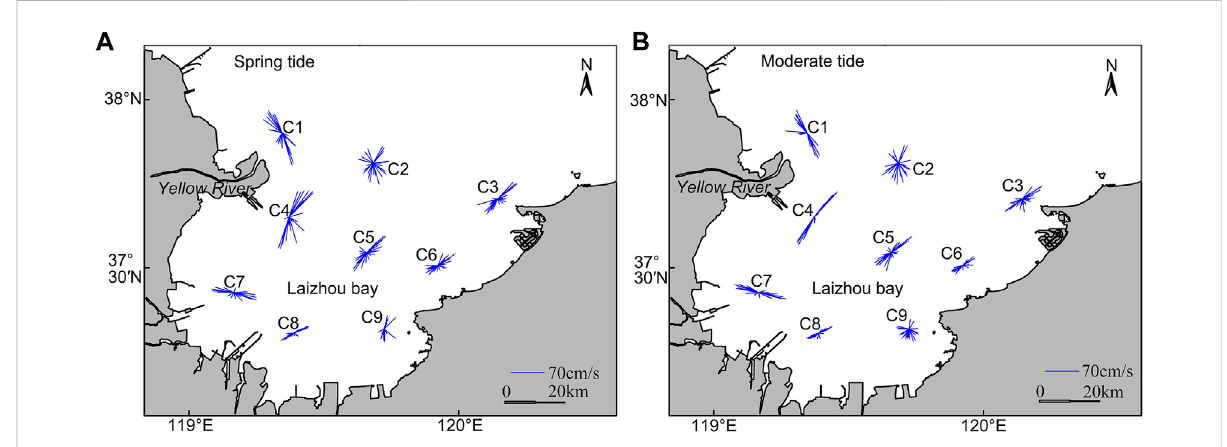
FIGURE 5 Vertical average tidal current at each station during the spring (A) and moderate (B)